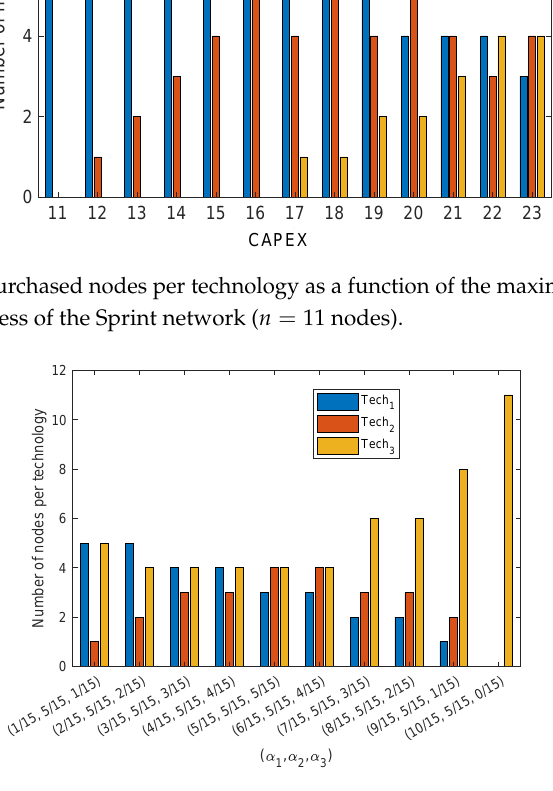
Figure 10. Number of nodes per technology parameterized by different selections of risk indexes. The values α 1 , α 2 , α 3 on the x -axis correspond to different selections for the risk indexes. Topology: Sprint network ( n = 11